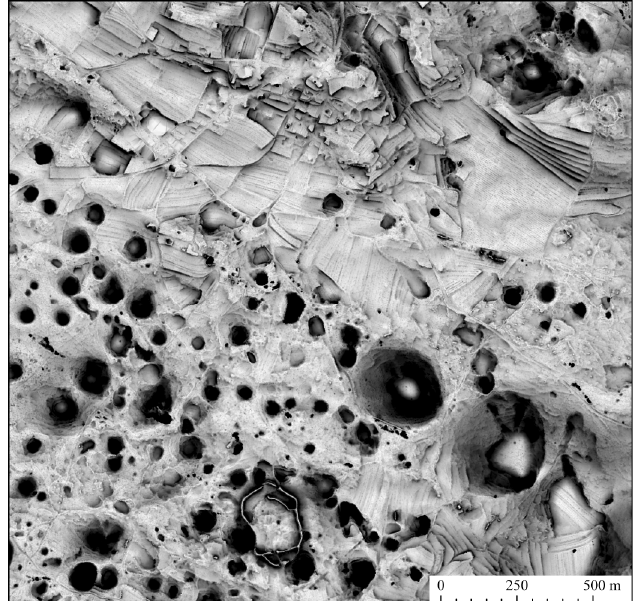
Figure 6. Visualization of dolines in a karstic area (Slovenia). The elevation model has a spatial resolution of 1 m. SVF was computed in 16 directions and a search radius of 30 m was used (similar to the diameter of the